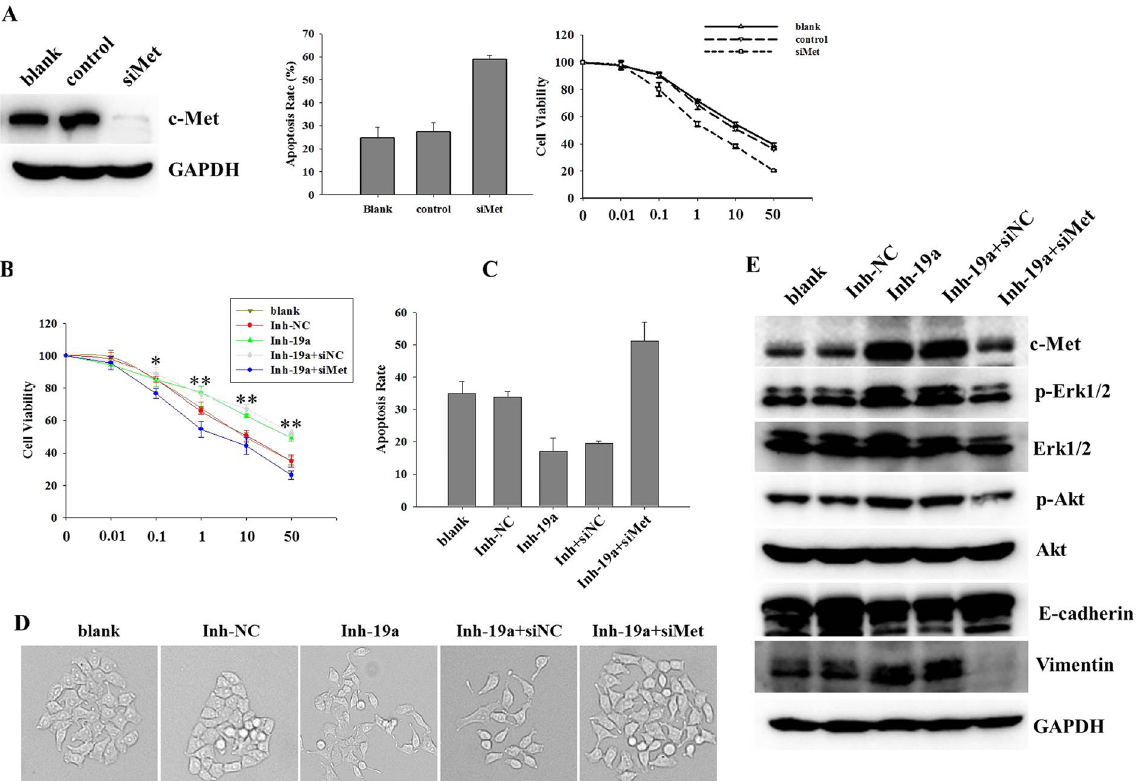
Figure 6. miR-19a reverses gefitinib resistance in NSCLC cells by targeting c-Met ( A ). A549 cells were transfected with c-Met siRNA (si-Met), and the c-Met protein level was detected with a western blot (left); the cells were transfected with si-Met and treated with gefitinib, and cell viability (right) and apoptosis rate (center) were measured after 48 h; ( B ) A549 cells were transfected with Inh-19a or co-transfected with Inh-19a and si-Met and treated with different doses of gefitinib for 72 h before measuring cell viability by CCK8; ( C ) The cells were transfected with Inh-19a or co-transfected with Inh-19a and si-Met and treated with 1 µ M gefitinib before examining apoptosis using the Annexin V-PI assay (mean ± sd, n = 3, ** p < 0.01); ( D ) The cells were transfected with Inh-19a or co-transfected with Inh-19a and si-Met; the cell morphology is shown; ( E ) The cells were transfected with Inh-19a or co-transfected with Inh-19a and si-Met, and the protein levels of c-Met and its downstream pathway effectors were detected in each